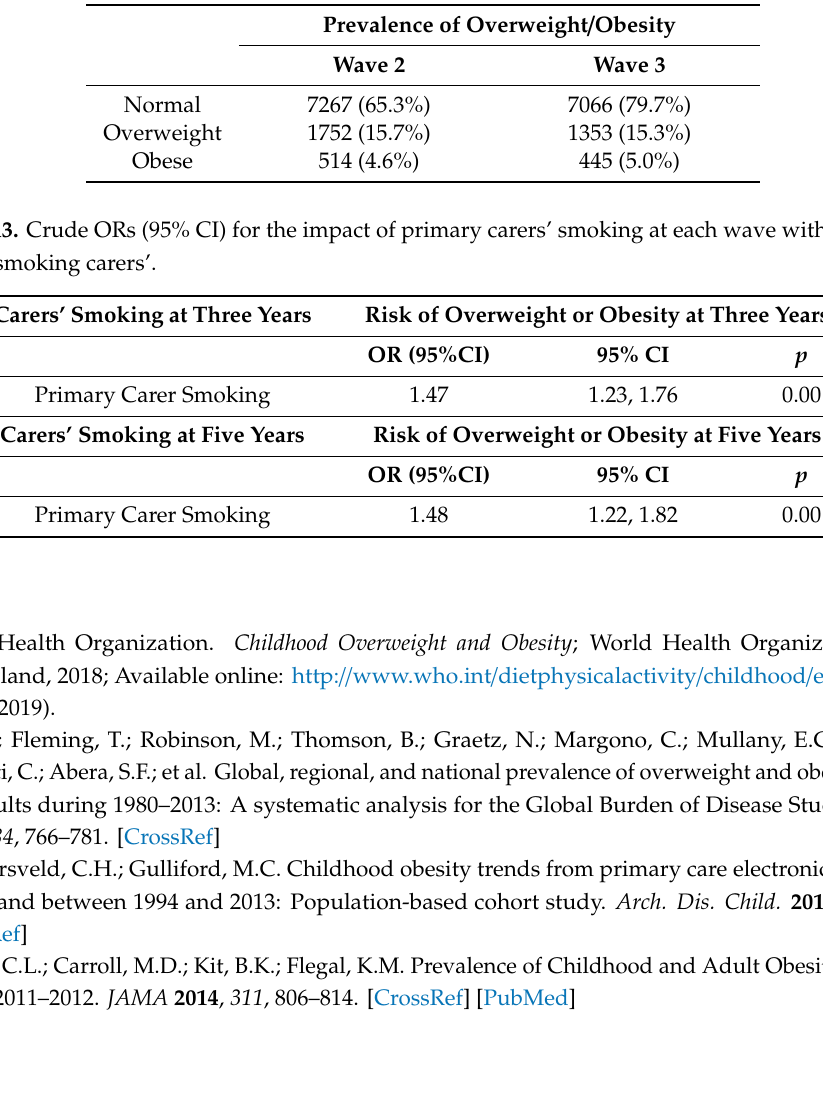
Table A2. Proportion of children with normal, overweight and obese BMI at each wave (Wave 2 and Wave 3).